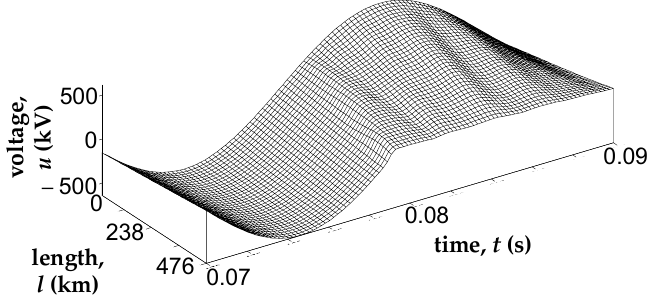
Figure 14. Temporal–spatial waveform of phase B current in the time range t ∈ (0; 0.02) s. Figure 14 indicates that phase B current, before energizing this phase, is very low, but above zero. This is related to the phenomenon of mutual induction.